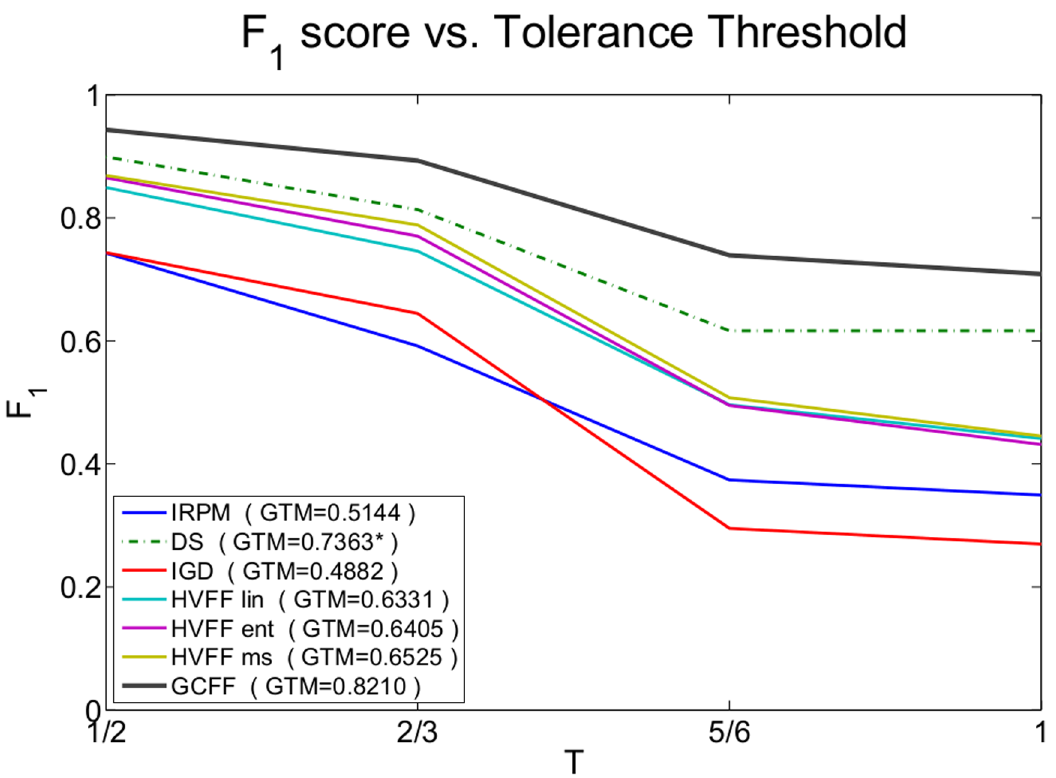
Fig 7. Global F 1 score VS . tolerance threshold T . Between brackets in legend the Global Tolerant Matching score. Dominant Sets (DS) is averaged over 3 datasets only, because of results availability. (Best viewed in colour)